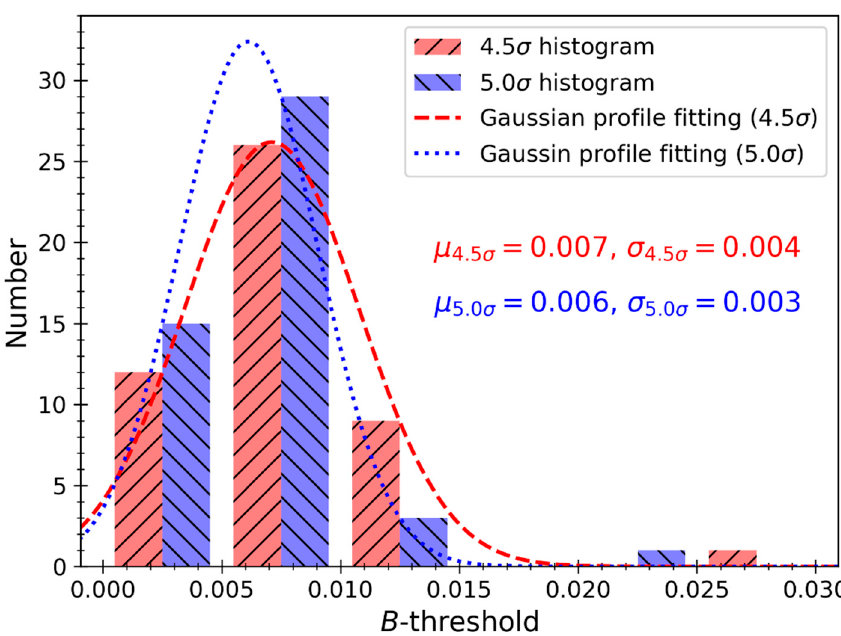
Figure 8. Histogram of the bottom thresholds at two different sigma values.